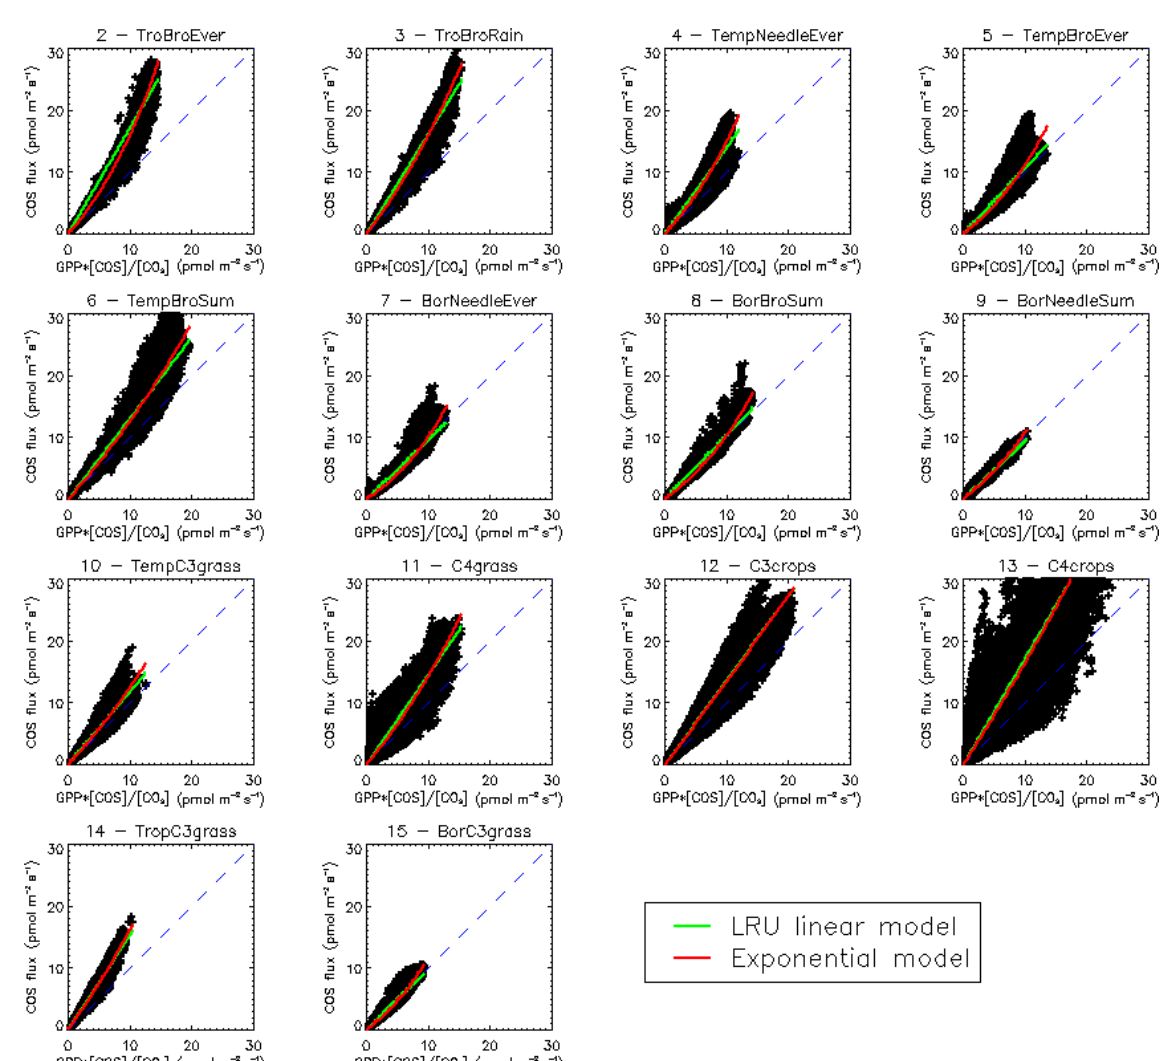
Figure C1. Scatterplots of COS fluxes against GPP multiplied by the ratio of COS to CO2 concentrations, using a climatology of monthly fluxes over the 2000–2009 period and yearly global averages for CO 2 concentrations and a fixed value of 500ppt for the COS concentration. Each subplot represents one of the 14 vegetated PFTs used in ORCHIDEE. The LRU model in green represents the linear regression, while the exponential model (see text) is represented in red. The blue dashed lines show the 1 : 1